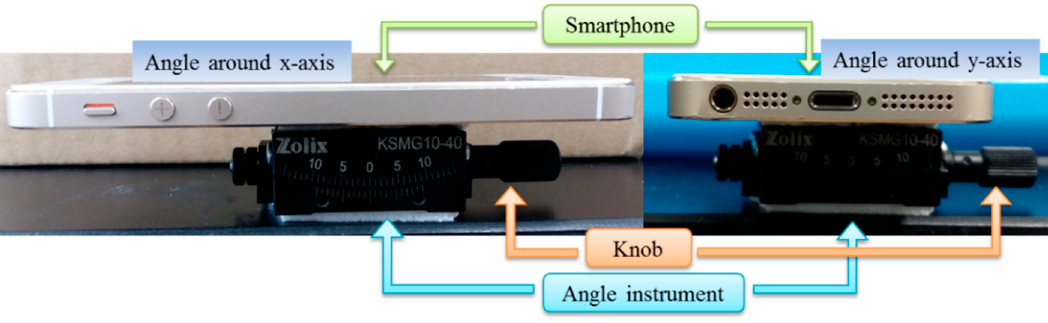
Figure 5. Photo of calibration experiment.